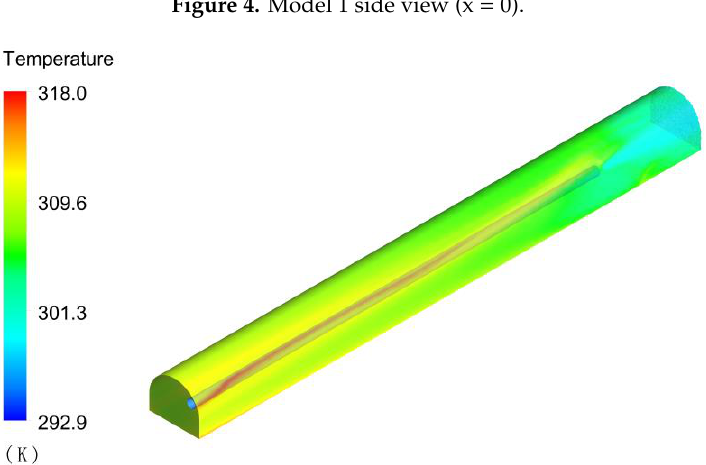
Figure 5. Three-dimensional distribution of Model 1 roadway temperature.